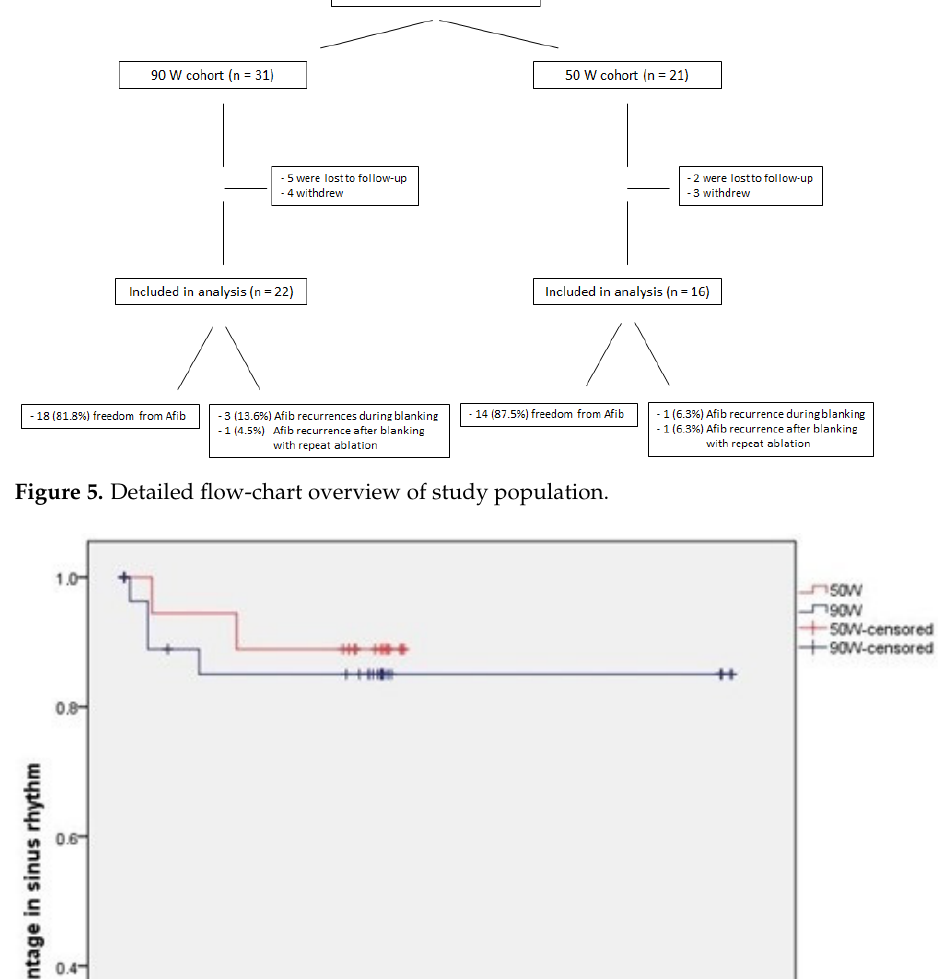
Figure 4. Long-term follow-up data.